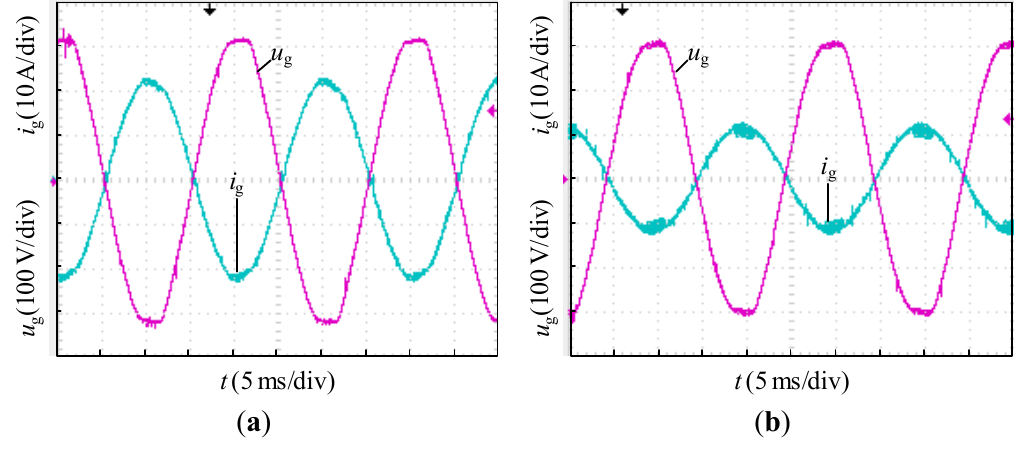
Figure 23. Grid voltage and current in the discharging mode: ( a ) u power; ( b ) u and i at 50% rated g g